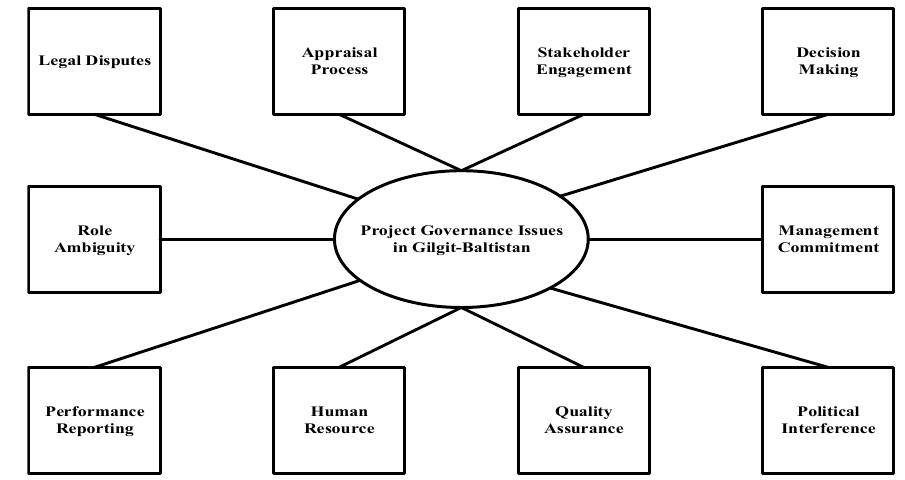
Figure 2. Project Governance Issues in Gilgit-Baltistan.